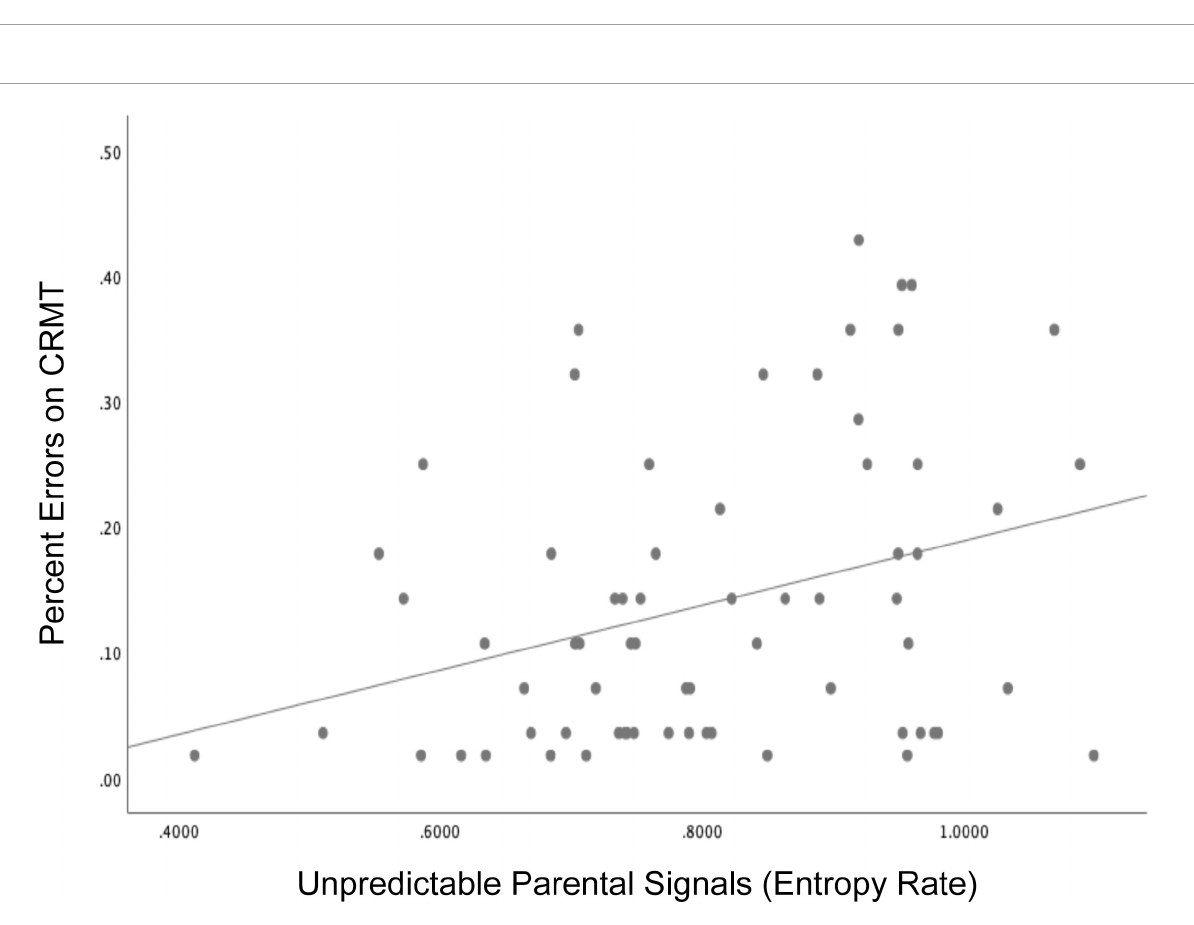
FIGURE3 Calculation of entropy rate in rodents: This time series of the seven possible states for one example litter in rodents (mice). This timeseries is then used to compute a transitional probability matrix. This matrix shows the percent of times a mother transitions from one state to another.